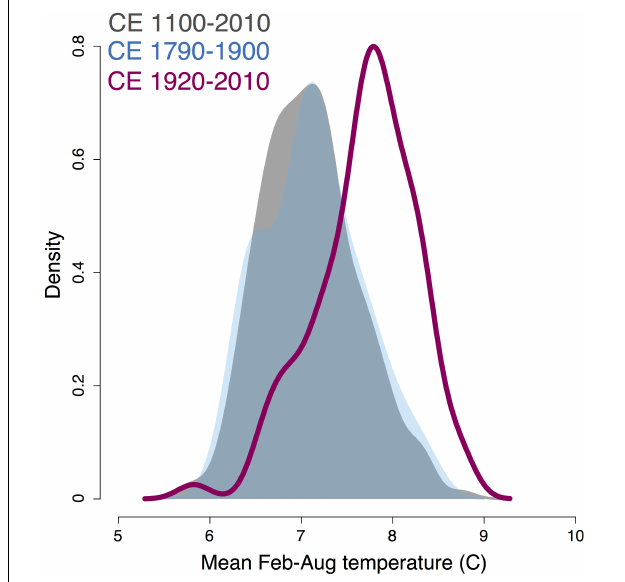
FIGURE 7 | Distribution of mean February to August temperatures based on tree-ring-width reconstructions (Wiles et al., 2014) for all years from CE 1100 to 2010, years when most coastal glaciers were advancing (CE 1790–1900), and years when most coastal glaciers were retreating (1920–2010). These data suggest that warm summers caused widespread glacier retreat after 1920, however, February to August temperatures are not exceptionally cold during the widespread advance observed during the 19th century.